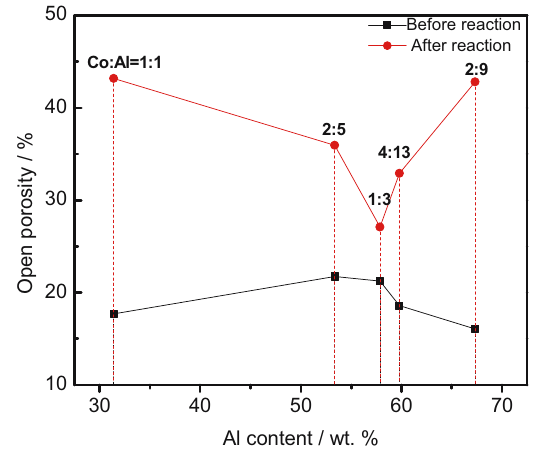
Figure 7: Open porosity of Co – Al intermetallics with different Co/Al molar